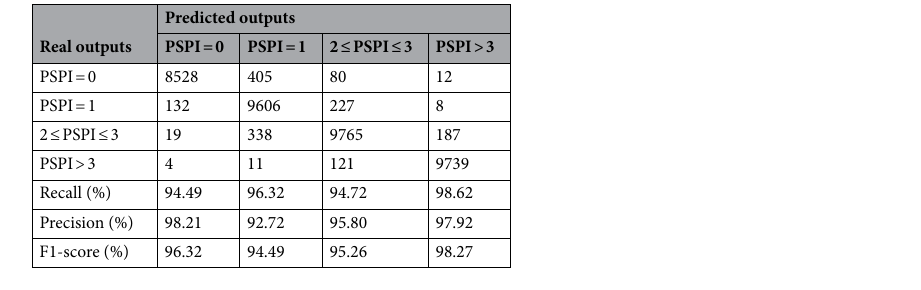
Table 3. Confusion matrix obtained for proposed shutter blinds model using DISFA Database with tenfold cross-validation.